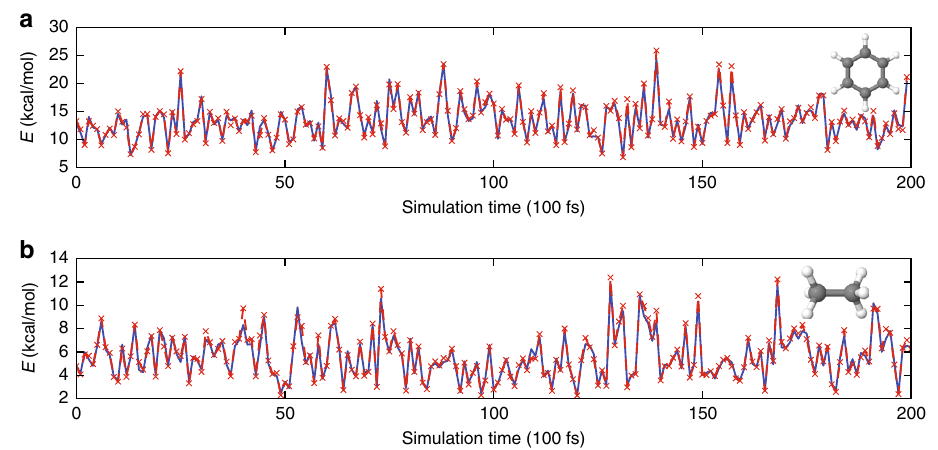
Fig. 3 Energy errors of ML-HK along classical MD trajectories. PBE values in blue , ML-HK values in red . a A 20 ps classical trajectory of benzene. b A 20 ps classical trajectory of ethane